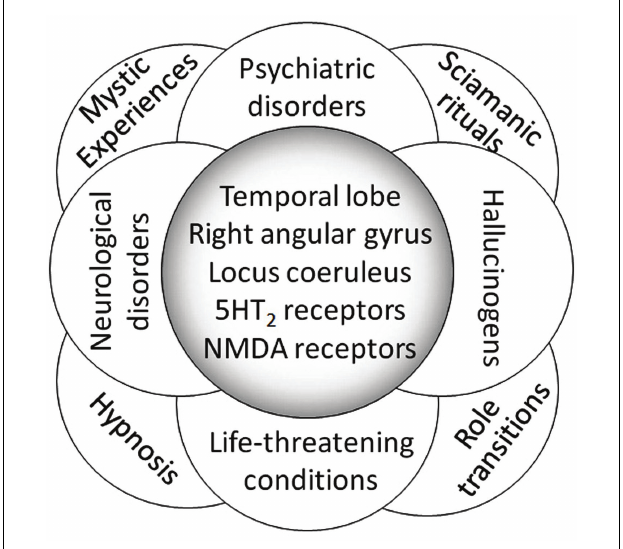
FIGURE 1 | Physiological and pathological contexts giving rise to NDEs, NDE-like experiences, and non-ordinary experiences of transcendental tone. These experiences might involve the same brain areas and neurotransmitters (an example of which is given here), and their dysfunctions seem to be understood rather better than their physiology.The latter belongs to the world of spirituality and the highest expressions of the human mind and culture, and the meaning of these experiences cannot be reduced a priori to a mere brain circuitry dysfunction simply because they look awkward from a materialistic